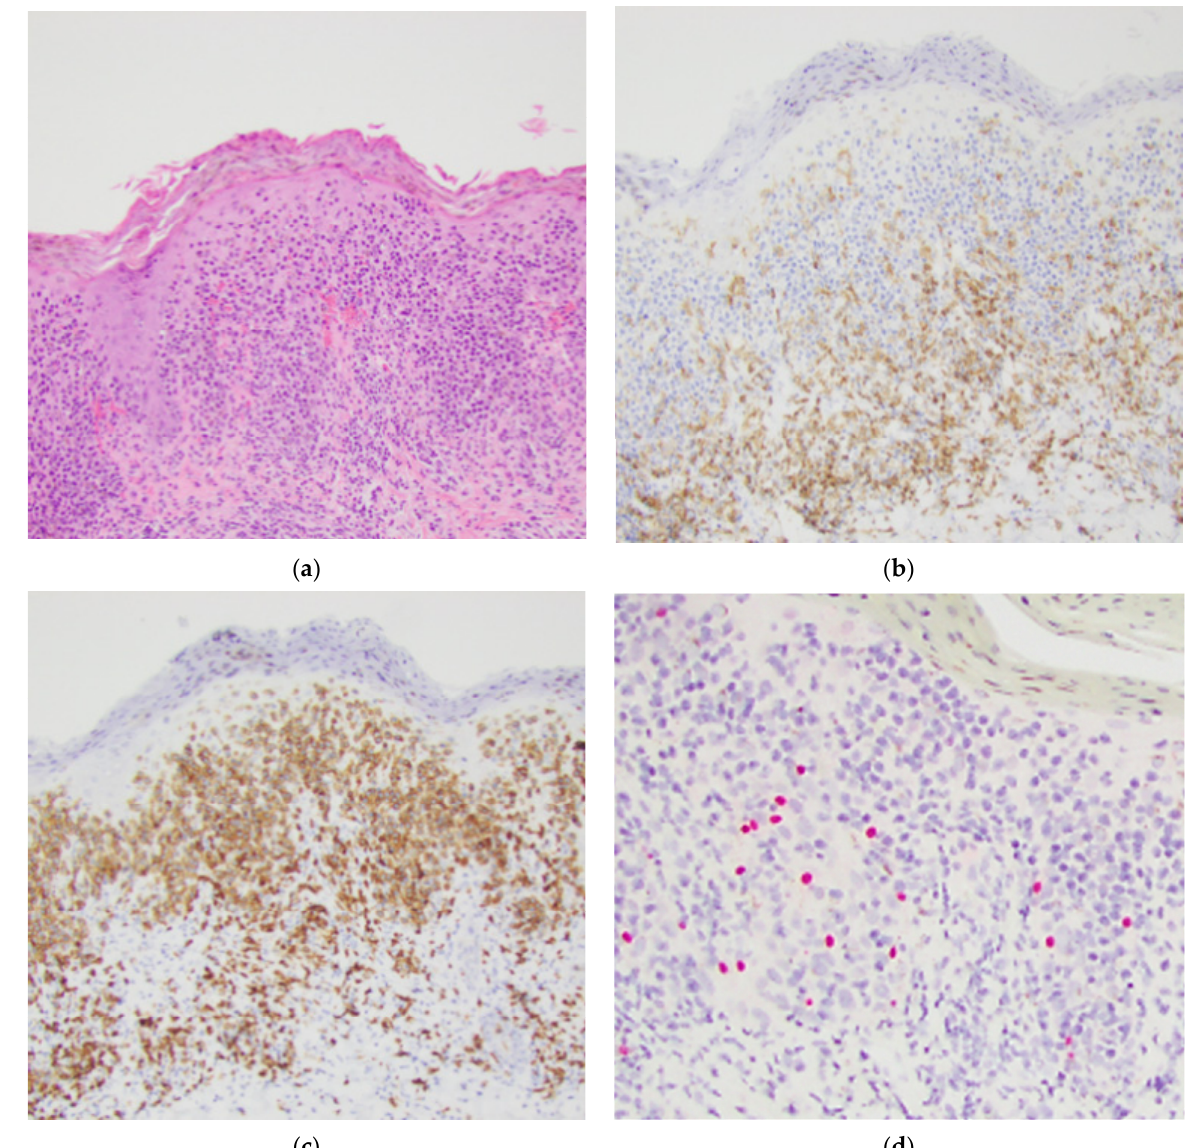
Figure 4. Sample case with a predominant CD8+ epidermotropic T-cell infiltrate with melanocytes in normal quantities and distribution highlighted by SOX10 IHC. The patient was a 40-year-old male with persistent pink to hyperpigmented patches in sun-protected areas. ( a ) Hematoxylin and eosin stained section, original magnification 100×. ( b ) T-cells highlighted by a CD4 IHC stain, original magnification 100×. ( c ) T-cells highlighted by a CD8 IHC stain, original magnification 100×. ( d ) SOX10 IHC highlighting melanocytes, original magnification 100×.